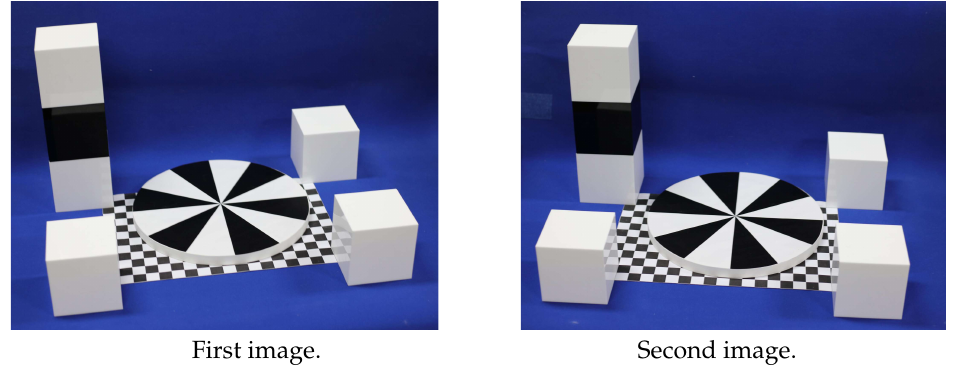
First image. Second image. Figure 6. Images of the model.